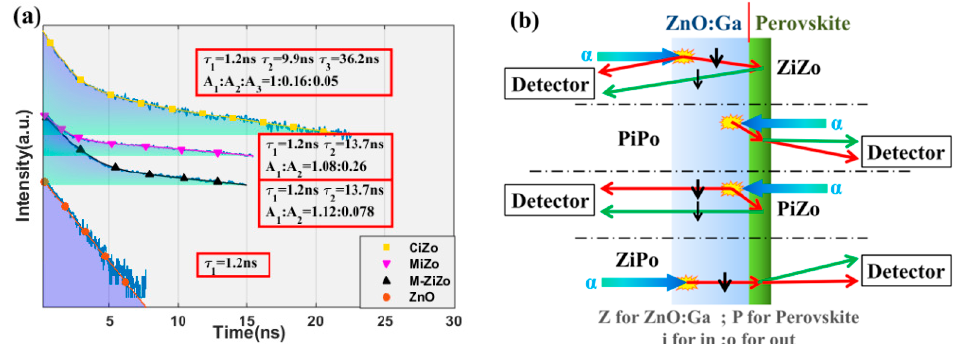
Figure 4. Decay times measurements of excitation by alpha particles collected from the GZO side: ( a ) decay curves of different samples and layouts; ( b ) optical transmission diagrams for 4 condi- tions.